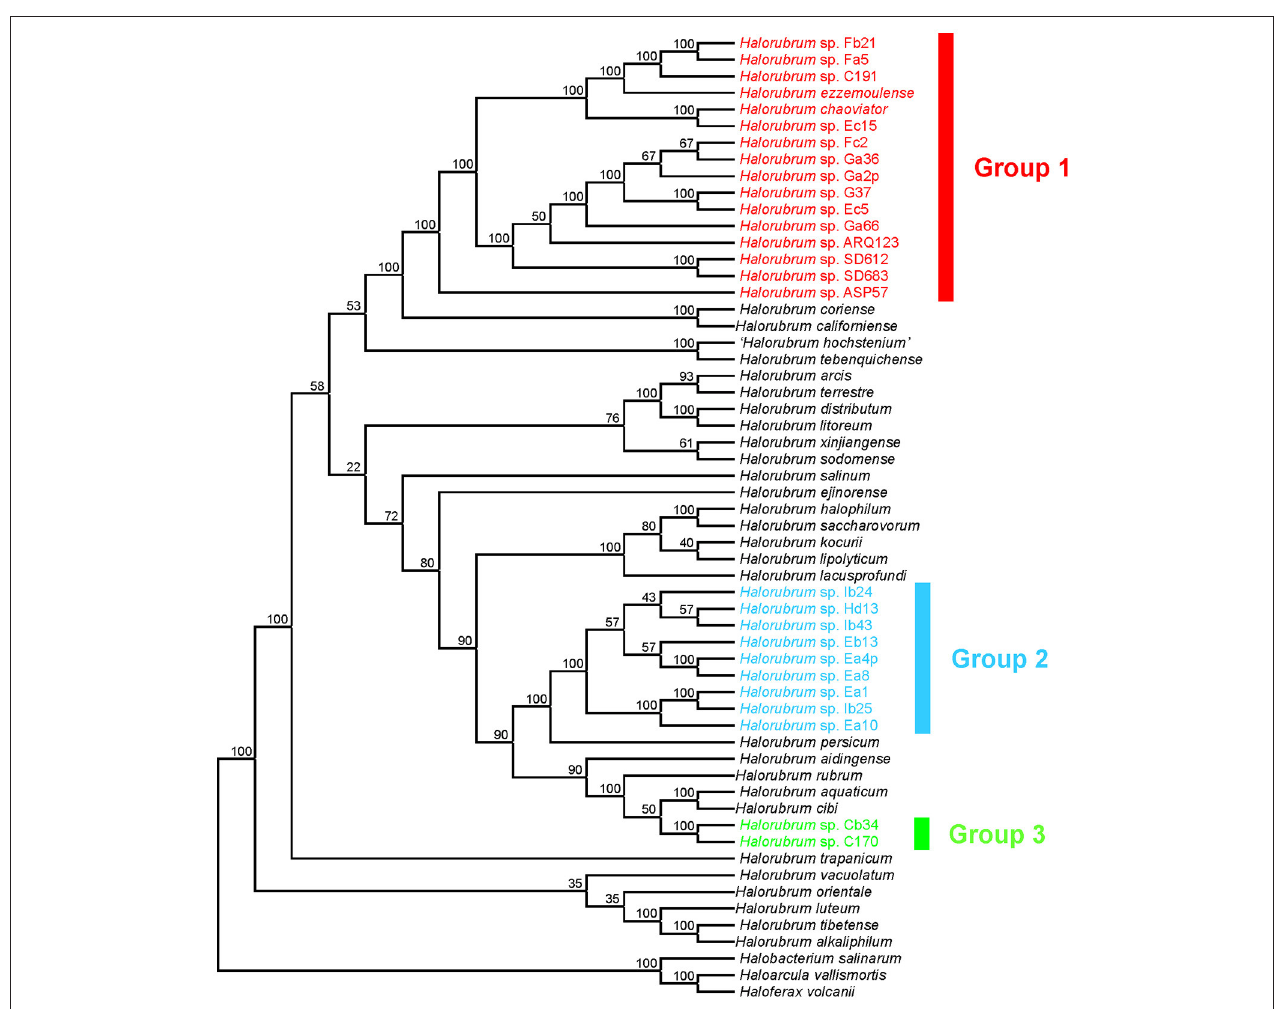
FIGURE 3 | Consensus supertree constructed on the basis of the five individual gene phylogenies by means of Matrix Representation using Parsimony (MRP) method showing the phylogenetic relationship between members of the genus Halorubrum and strains isolated in this study. The numbers represent the proportion of universally distributed input supertrees that contained that particular branch in the consensus supertree. The species Haloarcula vallismortis , Haloferax volcanii, and Halobacterium salinarum were used as outgroups. Different phylogroups have been marked with different